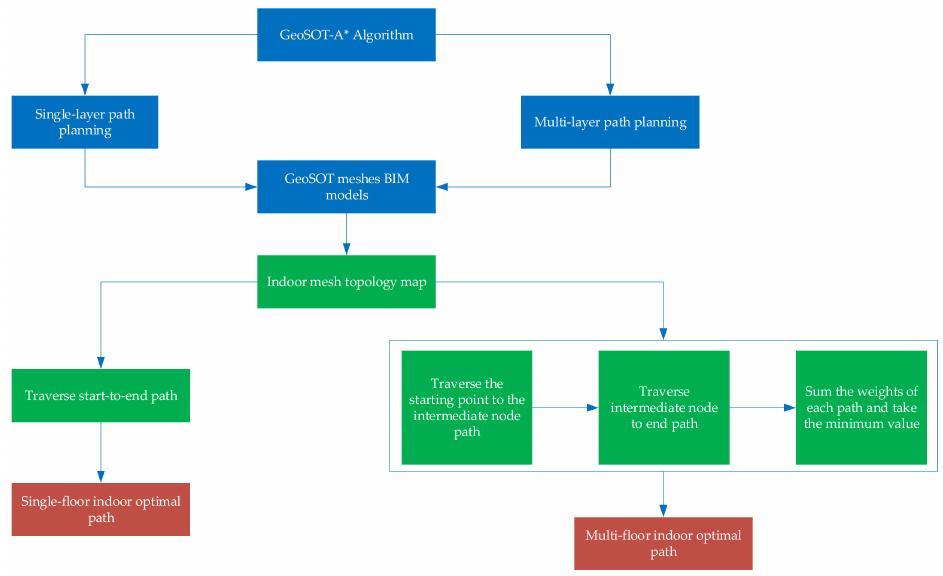
Figure 9. GeoSOT-A* algorithm